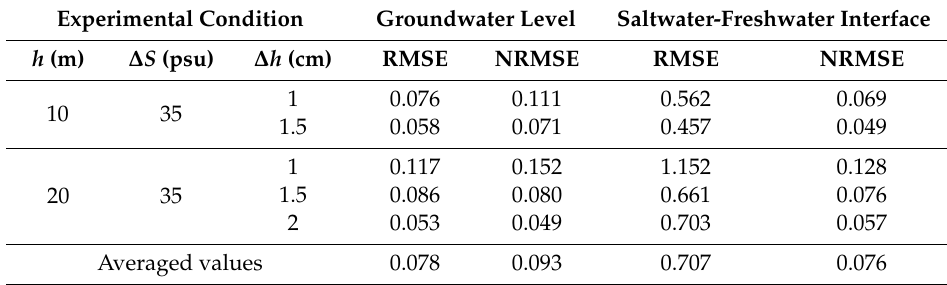
Table 3. Statistical comparisons between experimental and numerical results.